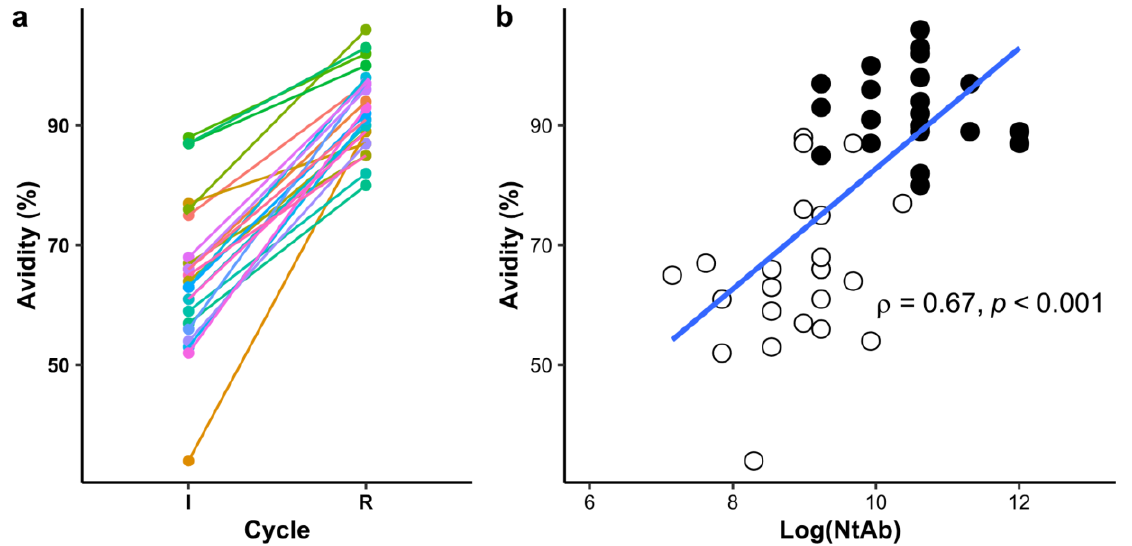
Figure 3. ( a ) Affinity maturation between hyperimmunization cycles. rRBD-specific avidity testing for IgG antibodies in HHS samples collected in each cycle at the moment of final blood extraction was analyzed as described in Section 2. Indi- vidual avidity scores (%) are grouped according to their respective immunization cycle (as stated in x -axis). Paired dot and lines are represented for everyone to aid visual inspection and analysis of both individual and group differences. Statistical inference analysis between groups is included in the text. ( b ) Correlation analysis affinity maturation and viral neutralization. Avidity on HHS of horses from the I (white circles) and R (black circles) were plotted against log trans- formed viral neutralization antibodies titers (Log(NtAb)). Spearman’s rank correlation coefficient is depicted in the chart together with the p value associated with rejecting the null hypothesis (that Avidity and Log(NtAb) are not correlated) whether it is true. A linear regression line is shown in blue to aid visual inspection of the data.